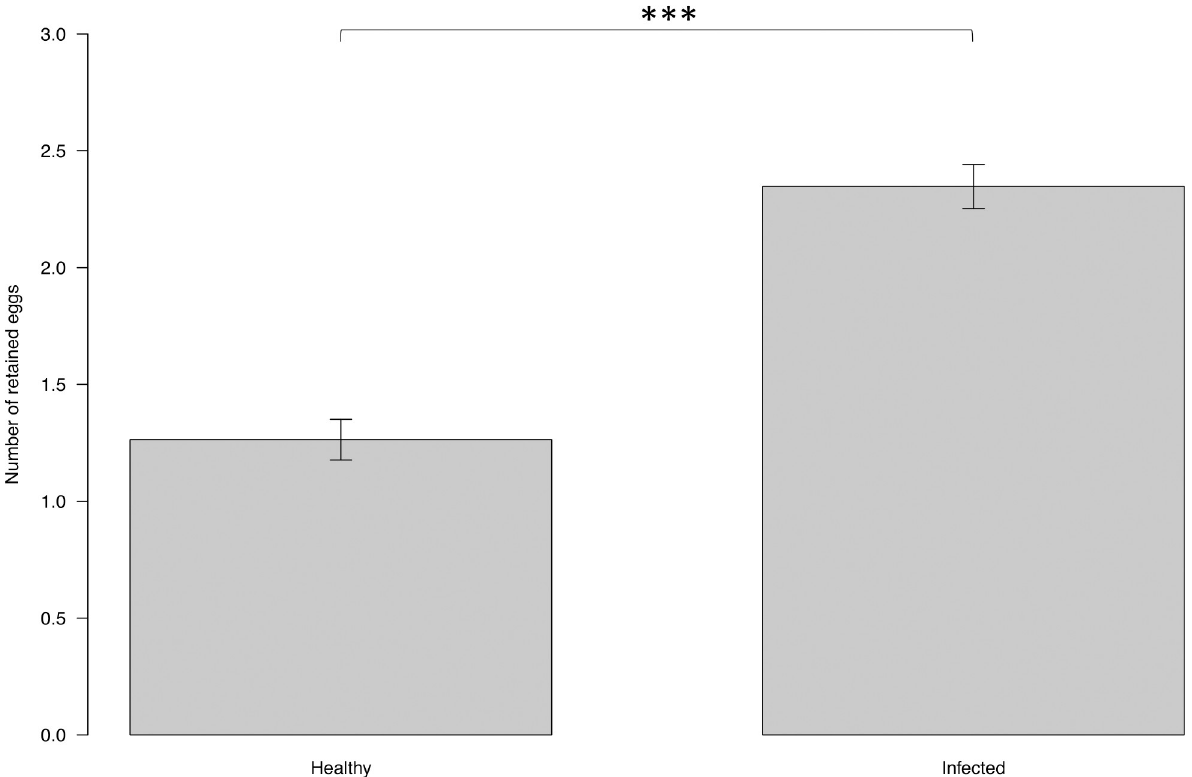
Fig 6. Mean number of retained eggs in P . perniciosus fed on uninfected vs. infected dogs under laboratory conditions. Y axis represents the numbers retained eggs in P . perniciosus fed on infected and uninfected dogs. X axis represents the infection status of the dogs. Significance code: p � 0.001 ���